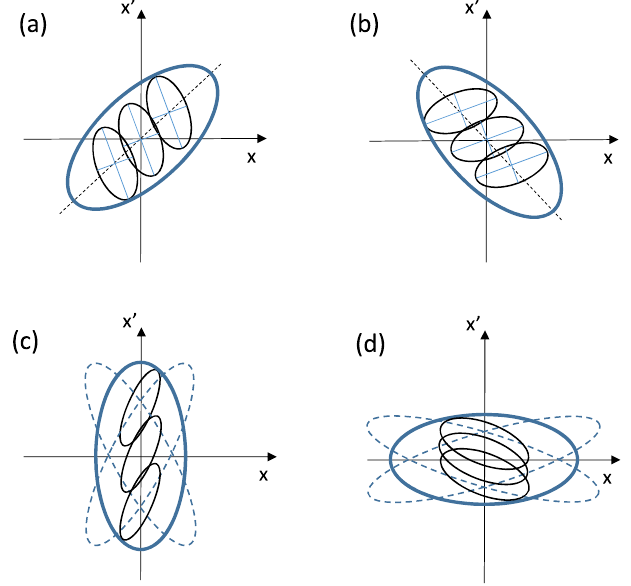
FIG. 2. Mechanism of emittance growth in the transverse phase space, due to kicks by collective effects (cartoon). (a) Two macroslices are displaced along the direction of the kick (dashed line) with respect to an unperturbed macroslice (inner centered ellipse). The projected emittance has grown (outer ellipse). (b) The same as in (a), after π = 2 betatron phase advance. The area of the outer ellipse remains constant after the kick. (c) The beam is matched at the entrance of the undulator to some design Twiss parameters. The optics is smooth in a way that Twiss parameters β and α vary little along the undulator (dashed outer ellipses). Since β is small, the macroslices are largely dispersed in angular u i ≠ 0 (solid line ellipse). (d)Thesameasin divergence;thatis, h θ 2 coll (c), but with β large. The macroslices largely overlap in angular u i → 0 (solid line ellipse). divergence; that is, h θ 2 coll